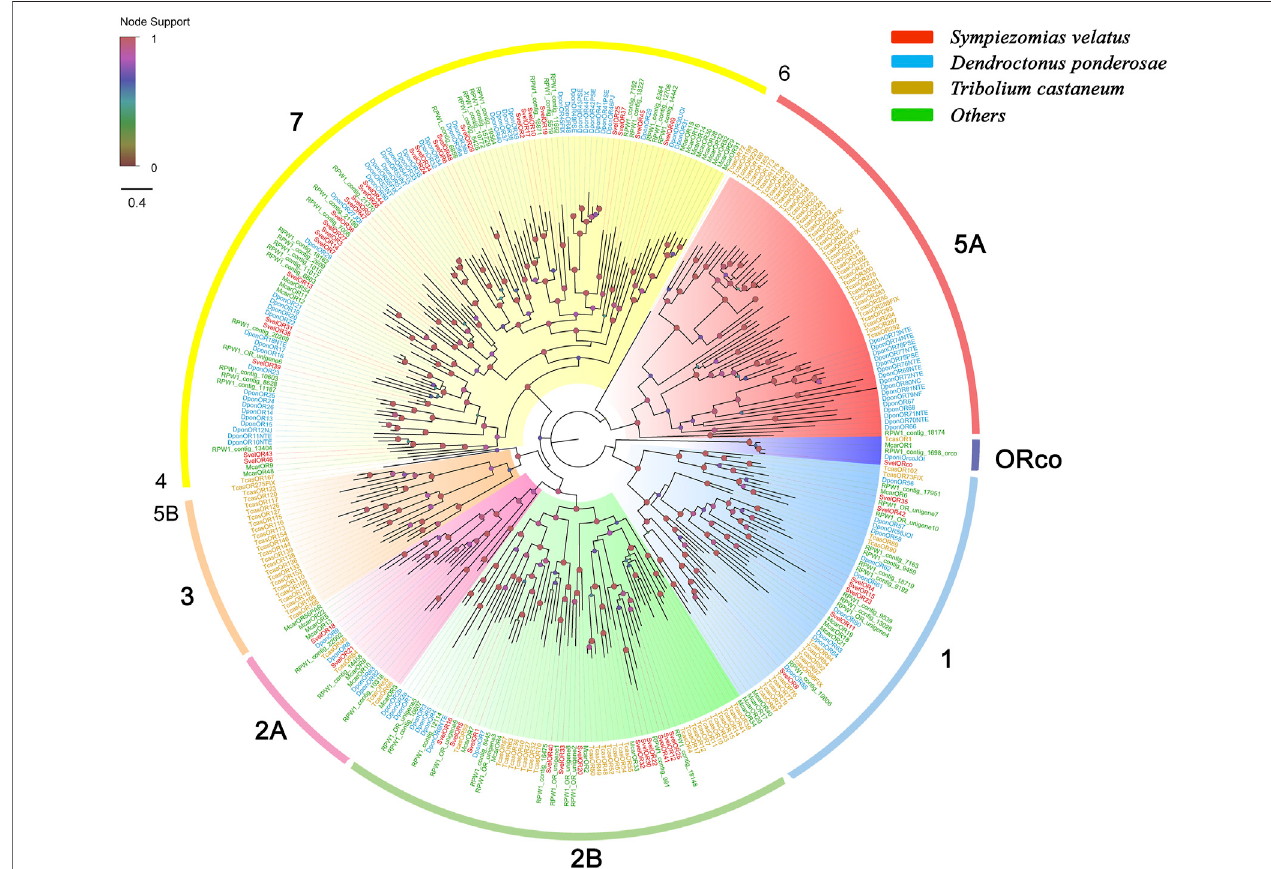
FIGURE 3 | Phylogenetic tree of candidate odorant receptors (ORs) rooted with the conserved odorant receptor coreceptor (ORco). The OR sequences included were from Sympiezomias velatus (Svel, red), Dendroctonus ponderosae (Dpon, blue), Tribolium castaneum (Tcas, yellow) and other species (green), including Megacyllenecaryae (Mcar)and Rhynchophorusferrugineus (RPW1_X).ThetreewasconstructedusingFastTreebasedonaMAFFTalignment.Thelocalsupportvalues based on the Shimodaira-Hasegawa (SH) test are indicated by the colored circles and increase with the brightness and size of the circles.